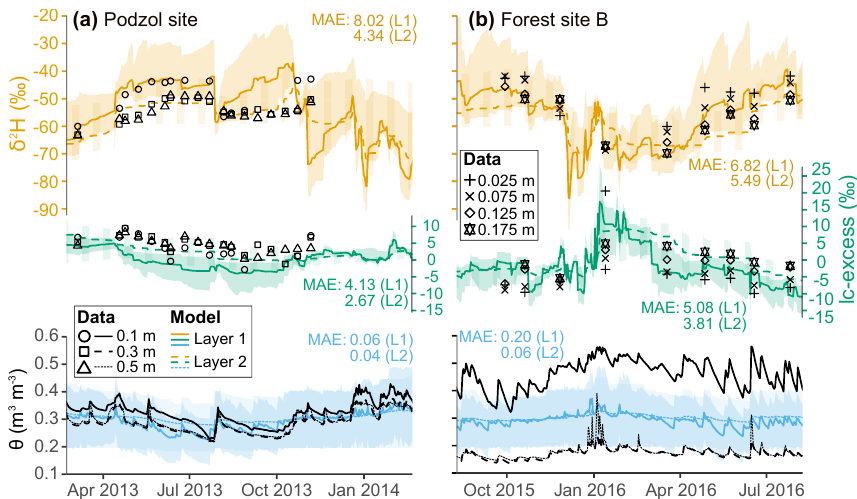
Figure 3. Time series isotopic composition ( δ 2 H – top, and lc-excess – middle) and soil volumetric water (bottom) at two sites located in the hillslopes: (a) one dominated by a heather shrub cover and (b) the other in a pine-dominated area. Black symbols and lines show measurements at a given depth while colours display the ensemble medians and 90% intervals of simulations in the two uppermost soil layers, and the median mean absolute error (MAE) values between model and data are